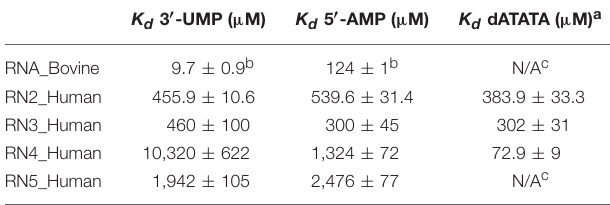
TABLE 1 | Binding affinities of functionally distinct RNases for RNA and DNA